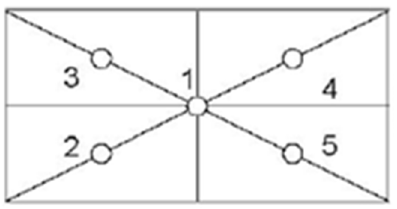
Figure 8. Eccentricity test position on a rectangular balance load receptor .